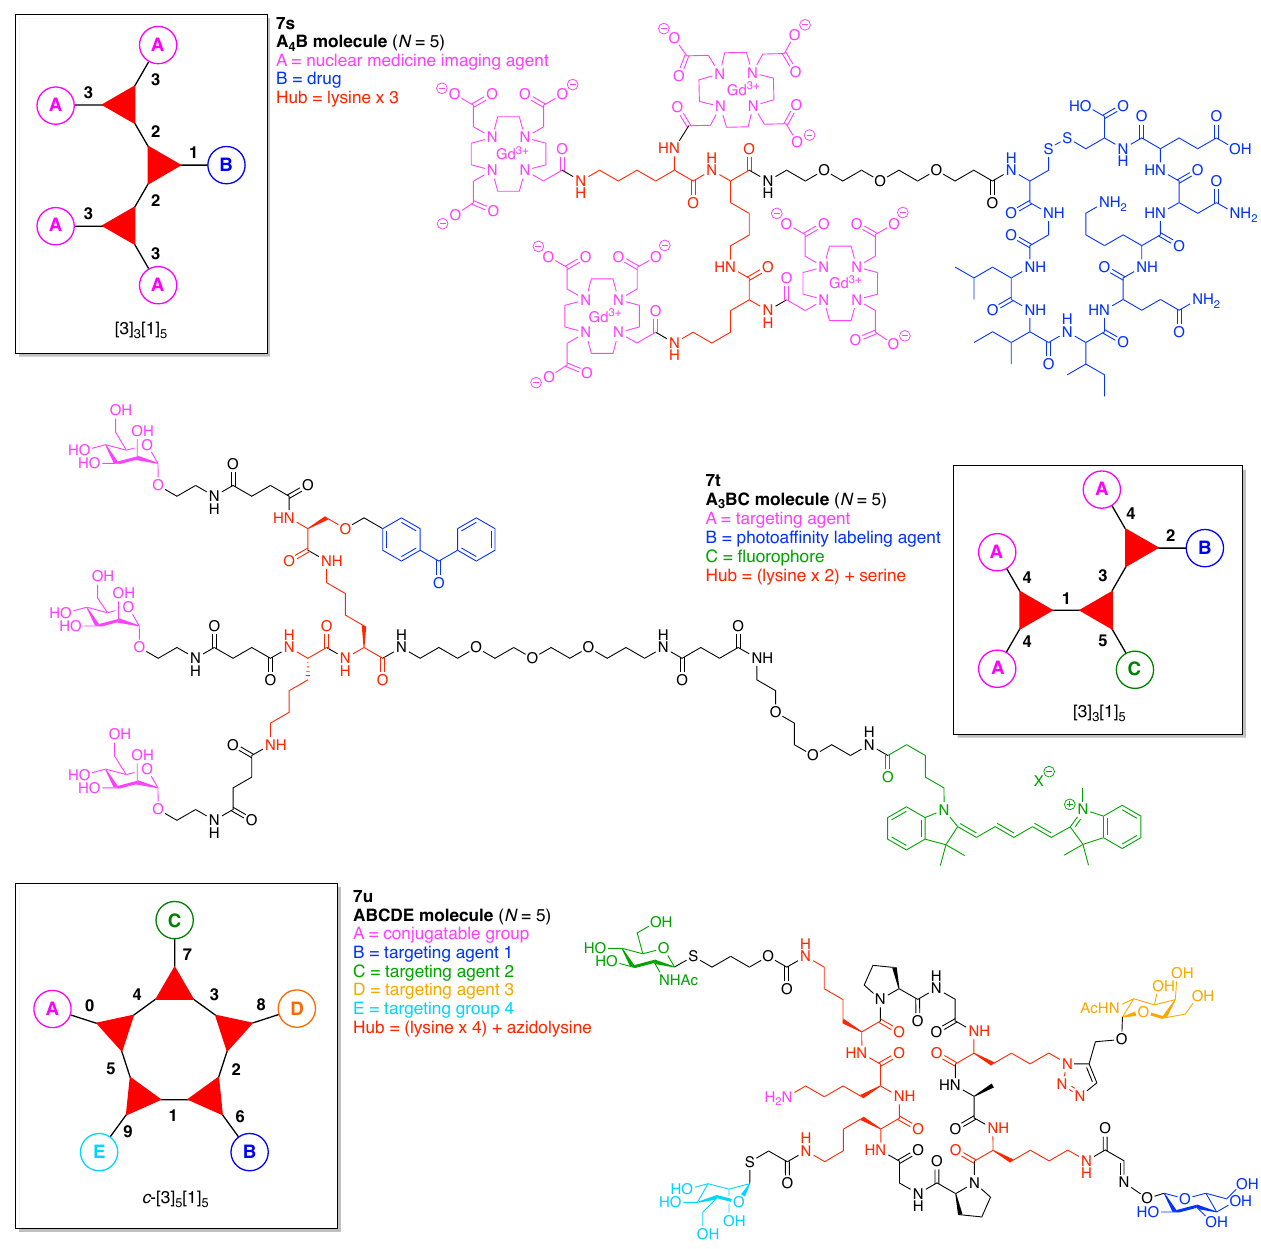
Figure 21. Examples each with two or more Lys hubs.